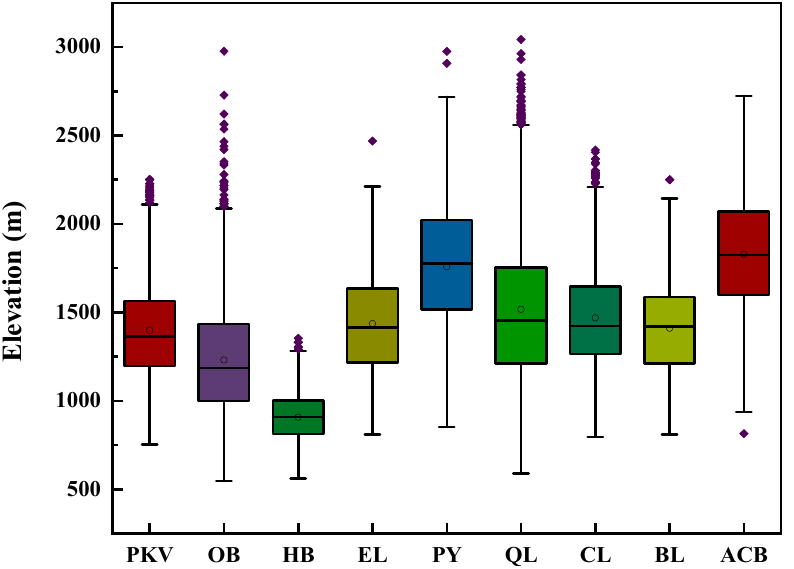
Figure 11. Box − and − whisker plot of tree species elevation distributions.